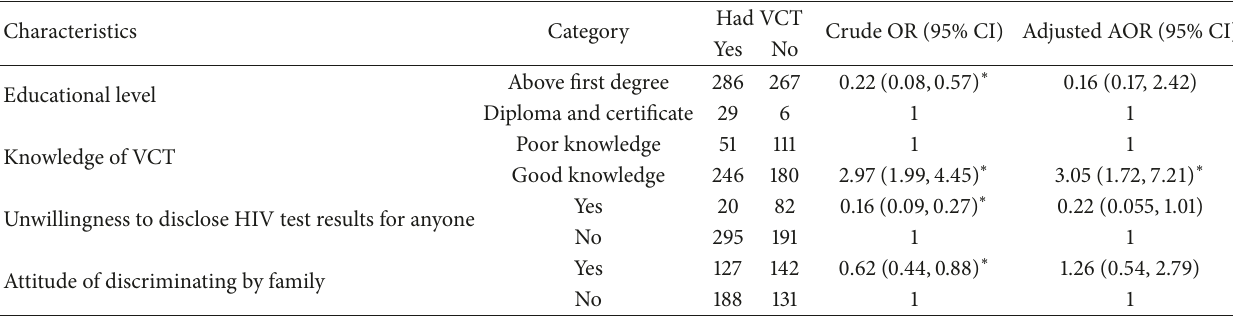
Table 6: Association of knowledge, attitude, and practices towards VCT service utilization, among secondary school teachers in Awi Zone, Amhara Region, Ethiopia,